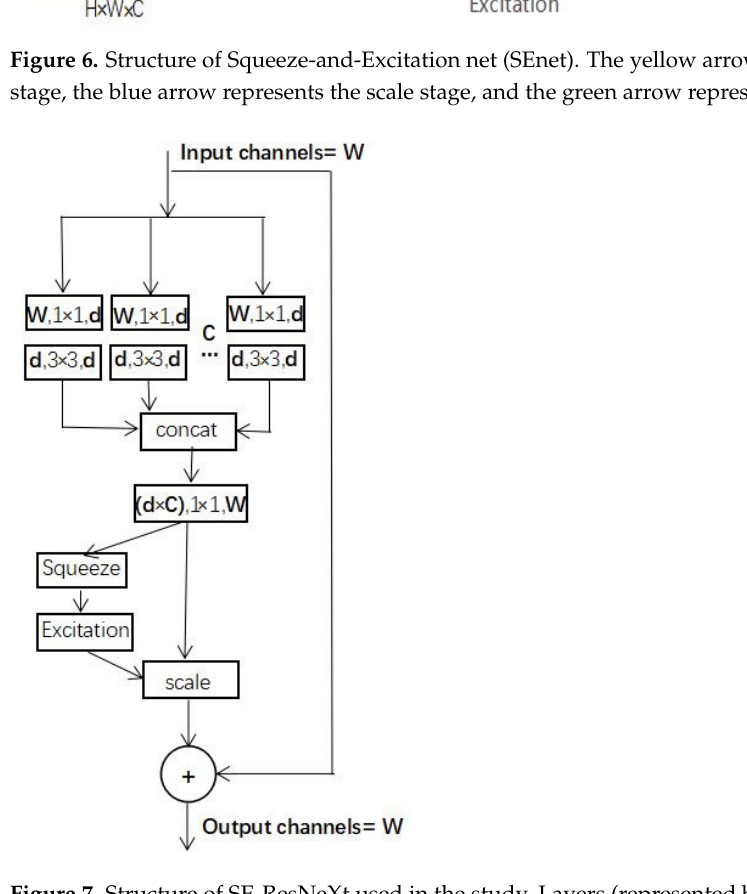
Figure 7. Structure of SE-ResNeXt used in the study. Layers (represented by a rectangular box) are expressed as (input channels, filter size, and output channels). C is cardinality. Squeeze, excitation, and scale are three stages of SEnet.